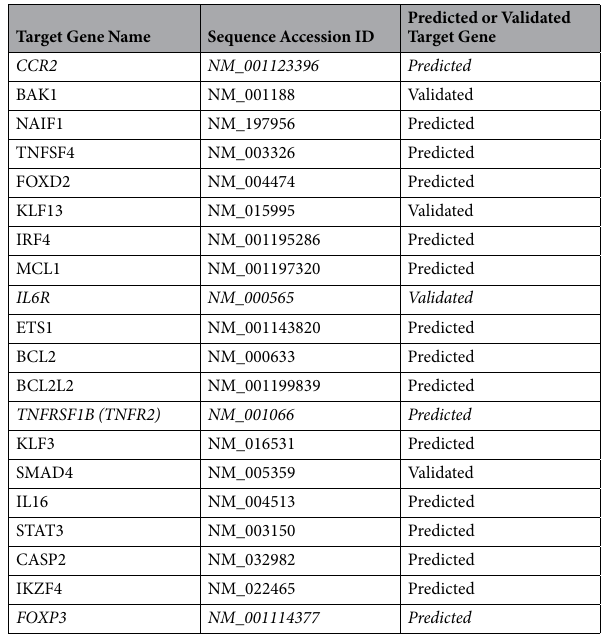
Table 1. MicroRNA miR-125a-5p target genes of interest. Predicted or Validated miR-125a-5p target genes relevant for T-cell and Treg-specific function, apoptosis, cytokine and chemokine signaling pathways, adhesion or migration functions are reported. Official target gene name alongside with Sequence Accession ID are indicated in the table. Target genes taken into consideration in the present study are reported in